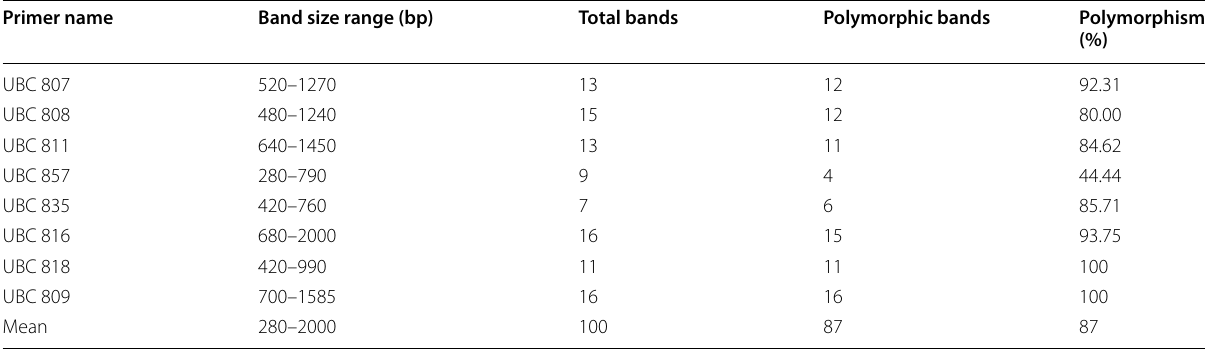
Table 5 Polymorphism indices for inter simple sequence repeats (ISSR) primers used for genetic diversity analysis in the Plantago maxima study